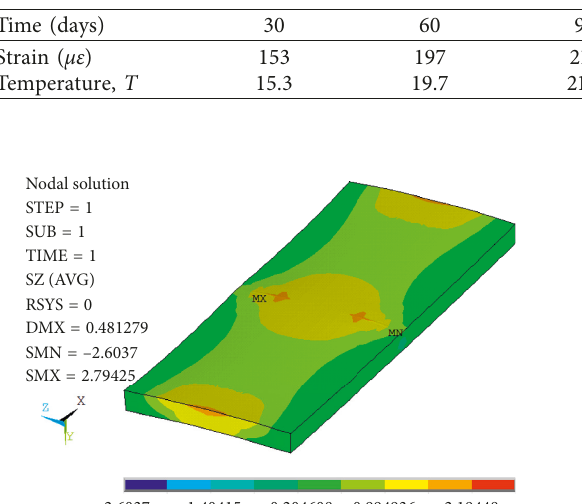
Table 2: Stress in Arch rib of different concrete